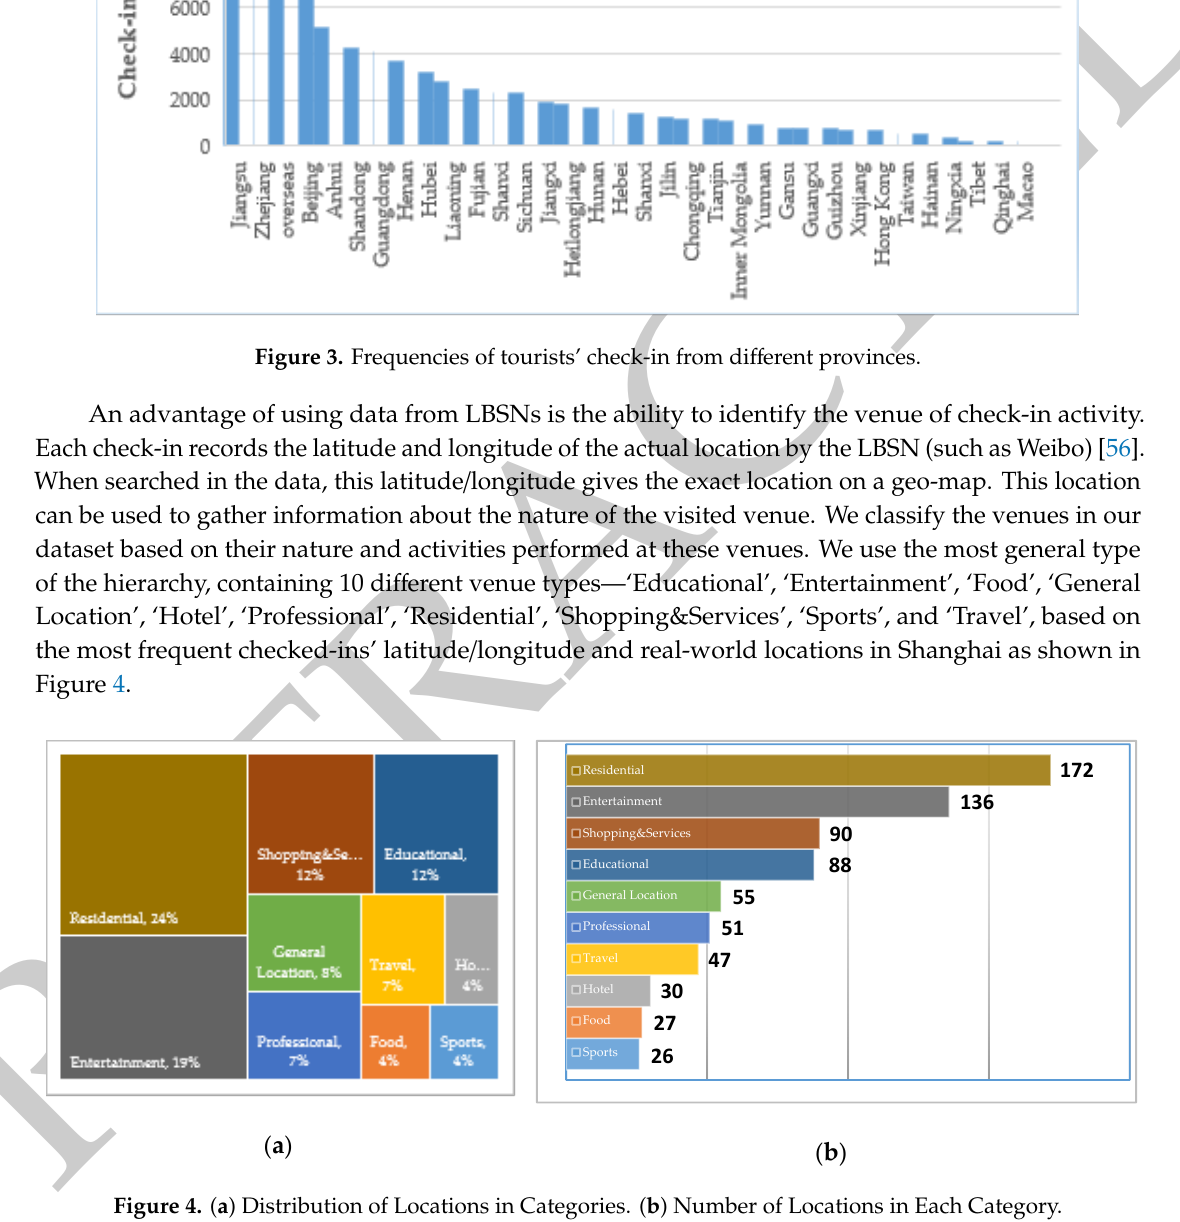
Table 2. Venue types visited by tourists and residents.